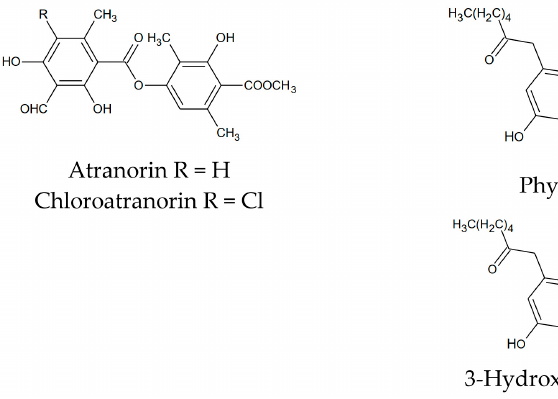
Figure 1. The main compounds present in Hypogymnia physodes .